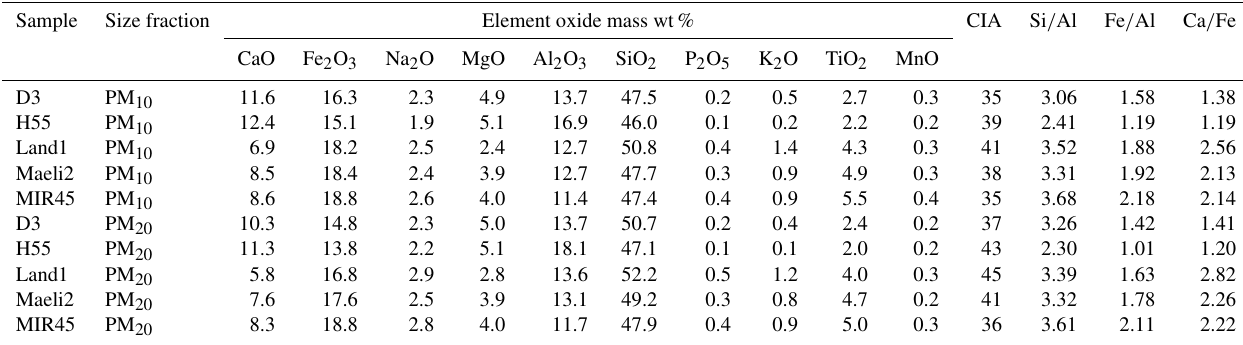
Table 1. Elemental oxide mass percentages, chemical index of alteration (CIA) and relevant elemental ratios in PM 10 (custom-made reactor) and PM 20 (CESAM